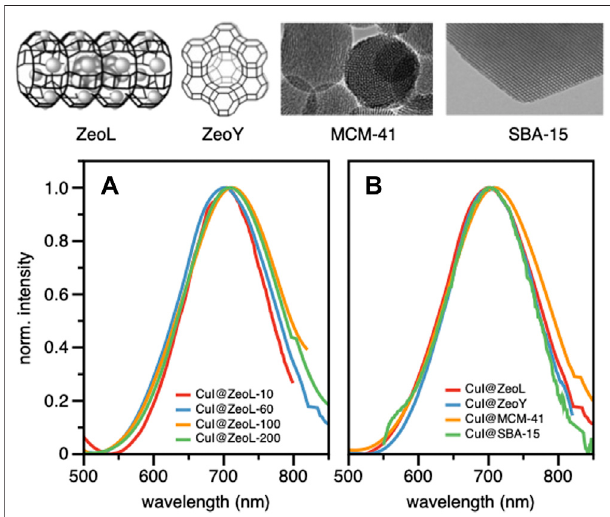
FIGURE 2 | Structure and TEM image of the different porous materials used in this work (top); emission spectra of CuI@ZeoL with different ratios of CuI:ZeoL (CuI@ZeoL-A red line; CuI@ZeoL-B: blue line; CuI@ZeoL-C: orange line;CuI@ZeoL-D: greenline) (A) ;effect ofhost/pore sizetothe emission spectra (B) in solid-state condition. On top of the graphs is depicted the representation of the host used in Figure 2B λ exc = 414 nm.